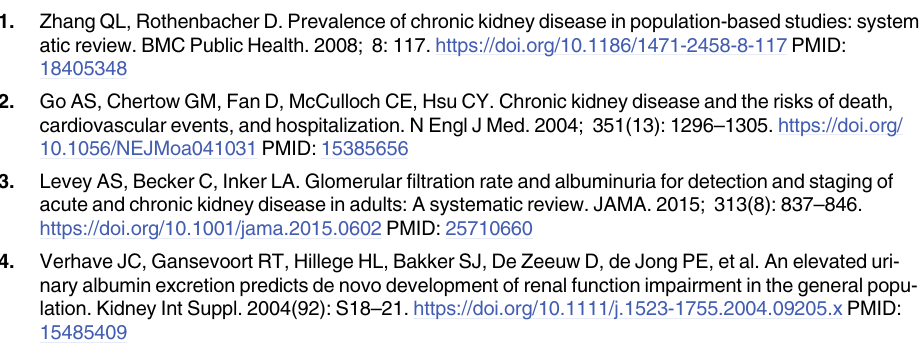
S1 Table. The adjusted eGFR levels according to sleep duration. S2 Table. Association between urinary albumin-creatinine ratio (UACR) levels and sleep duration according to age and gender. S3 Table. Proportion of patients with micoalbuminuria and macroalbuminuria according to sleep